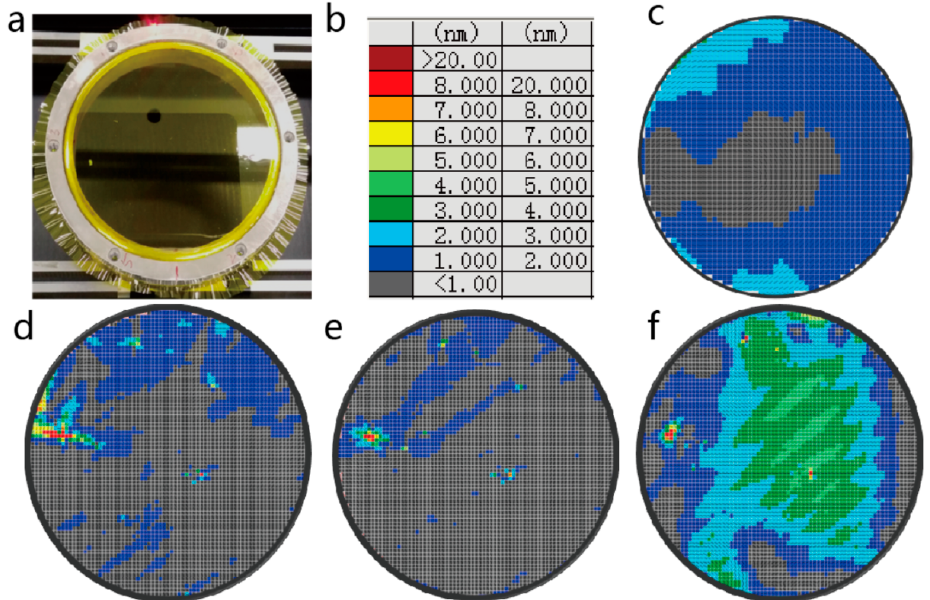
Figure 9. Stress birefringence distribution of circularly stretched PI membrane. Photo of sample ( a ), legend description of color map ( b ), color map of sample with no stretching force ( c ), color map of sample stretched by upper ring fixture gravity ( d ), color map of sample fully stretched by upper ring fixture ( e ), and color map of sample fixed with screws ( f ).